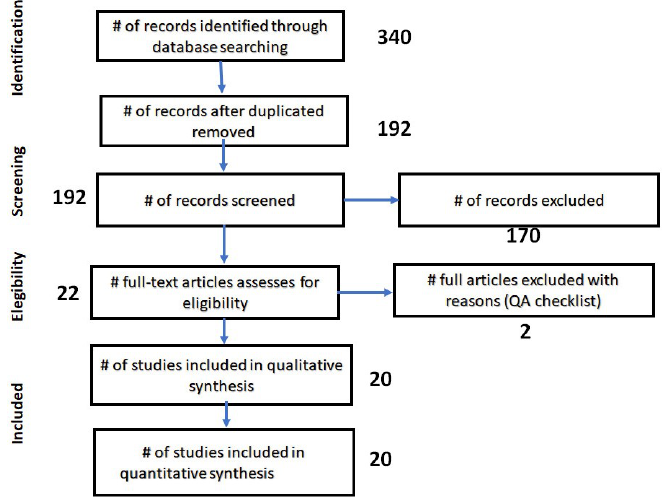
Figure 1. Systematic Review phases (adapted from